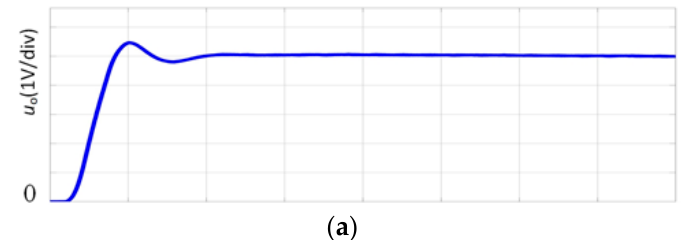
Figure 7. The three-module parallel simulation model: ( a ) The main circuit model of a three-module system during the parallel simulation; ( b ) control loop model of a three-module system during the parallel simulation.